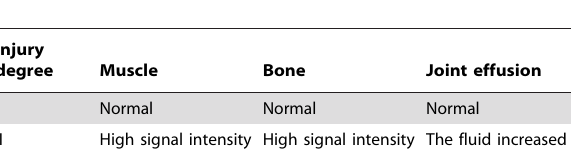
Table 3. The classification of injury of the bone, muscle and joint